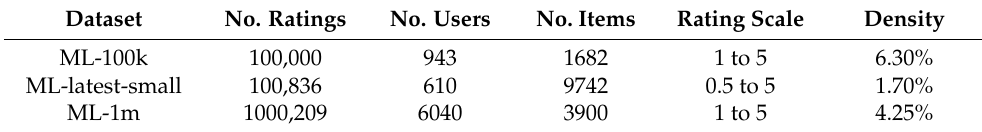
Table 1. Details of the